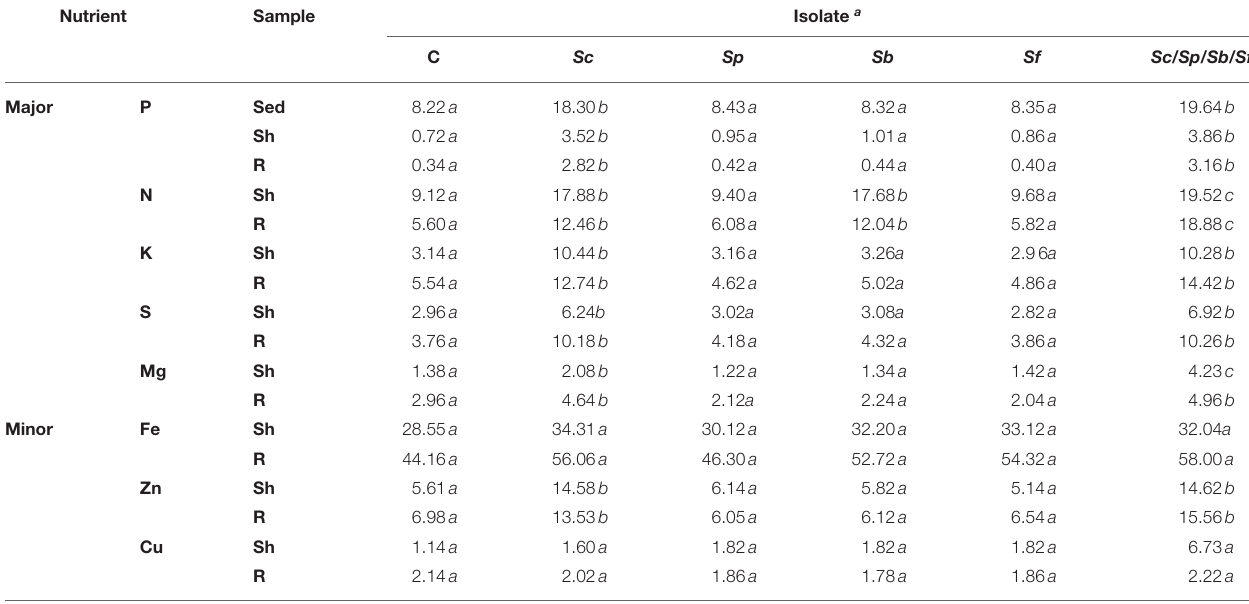
TABLE 3 | Effect of plant growth-promoting actinobacterial isolates on available P concentration in sediments (mg kg − 1 ) and major (g kg − 1 ) and minor (mg kg − 1 ) nutrients in the shoot and root tissues of mangrove ( Avicennia marina ) grown under greenhouse conditions at 28 ± 2 ◦ C.